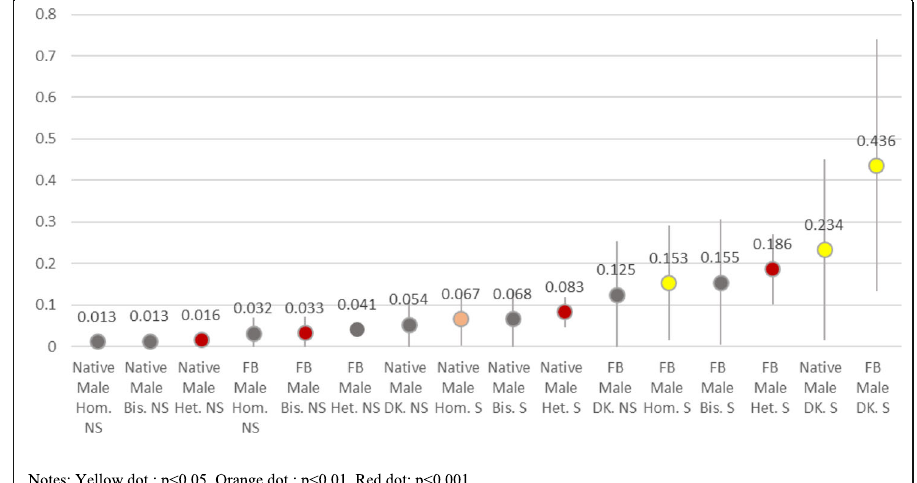
Fig. 2 Probability of previous experience of SVV for male students according to the place of birth, sexual orientation, and previous sexual experience with someone of the same sex. Adjusted predictions, other variables at the means. Notes: yellow dot: p < 0.05, Orange dot: p < 0.01, Red dot: p < 0.001. Sexual orientation: Hom = homosexual, Bis = bisexual, Het = heterosexual, DK = does not answer, previous same- sex sexual experience: NS = no, S = yes, FB =